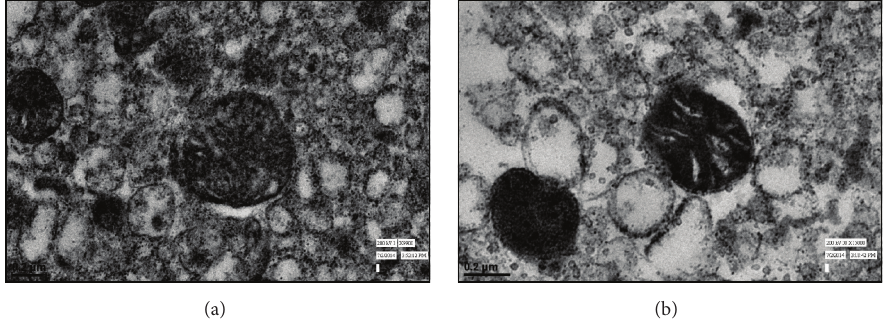
Figure 7: Transmission electron microscopic analysis of mitochondrial surface before and after the treatment of KCl showed mitochondrial swelling, altered morphology of cristae, and disruption in outer mitochondrial membrane after KCl treatment. (a) Ultrastructure of control mitochondria and (b) ultrastructure of KCl-treated mitochondria.